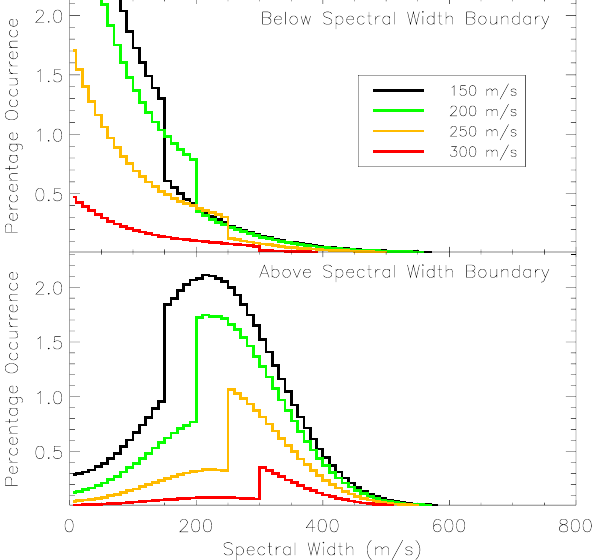
Fig. 7. A comparison of the actual spectral width distributions em- ployed in the simulations (black lines) and the effective distributions that result after spatially and temporally median filtering the data as in algorithm 3 (yellow